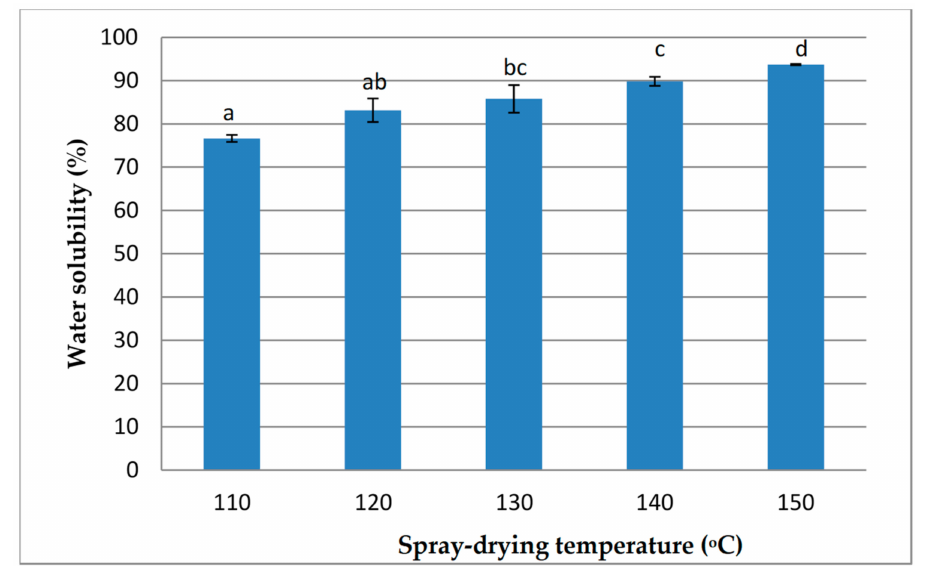
Figure 3. Water solubility (%) of lemongrass leaf extract powders at different spray-drying temperatures. All data are the mean ± SD. Values with different letters are significantly different ( p <